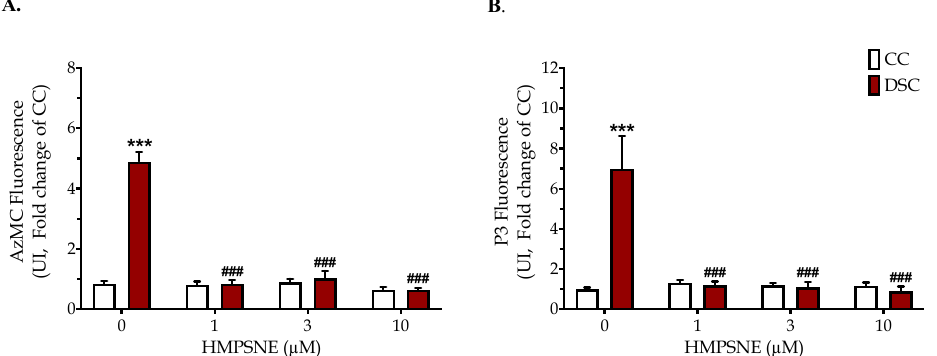
Figure 3. The 3-MST inhibitor HMPSNE suppresses H 2 S levels in Down syndrome cells. Fluorescence values of the H 2 S probe AzMC ( A ) and P3 ( B ) are shown in healthy control Detroit 551 fibroblasts (CC) and in Down syndrome Detroit 539 (DSC) fibroblasts under baseline conditions and when treated with 1, 3 or 10 µ M HMPSNE for 24 h. Each bar represents the mean ± SEM of 4 independent experiments. *** p < 0.001 indicates a significant increase in fluorescence in DSCs vs. CCs; ### p < 0.001 indicates a significant inhibitory e ff ect of HMPSNE on cellular H 2 S levels in DSCs.